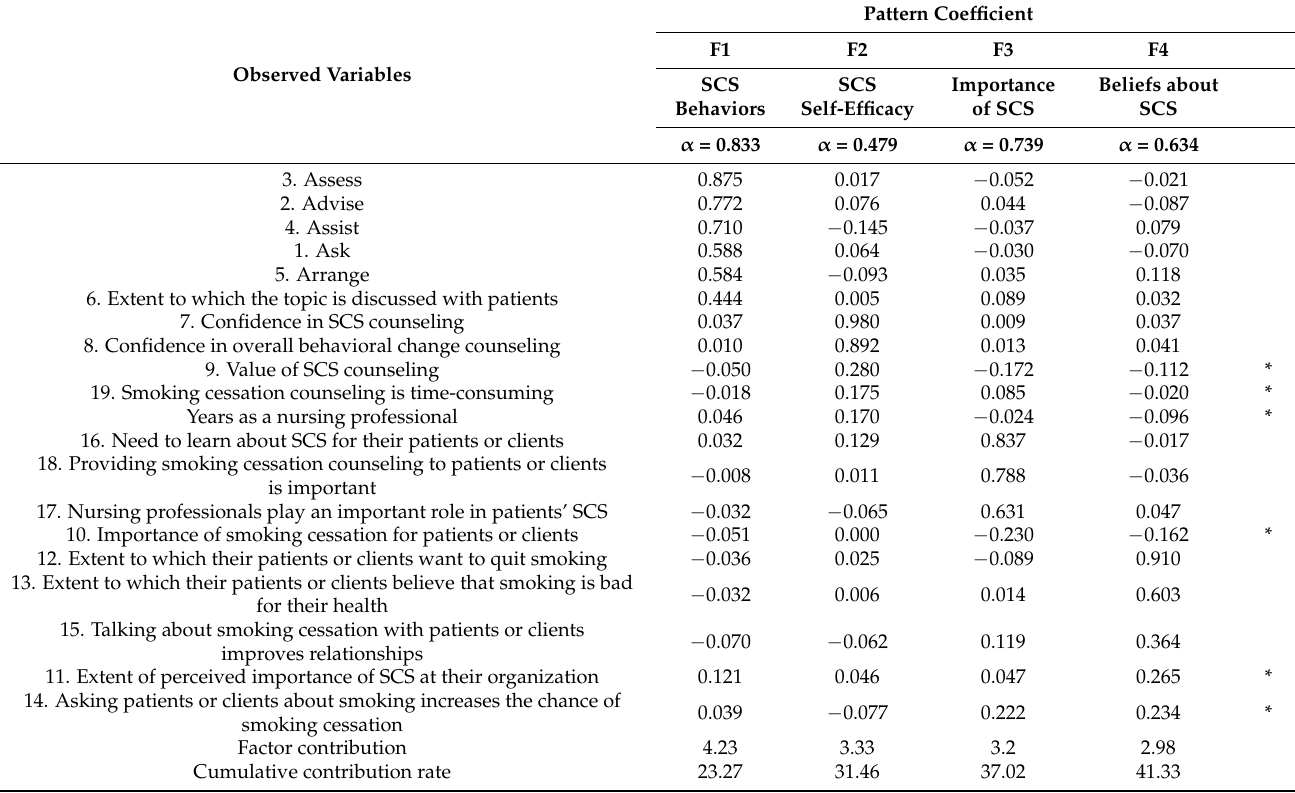
Table 3. Exploratory factor analysis